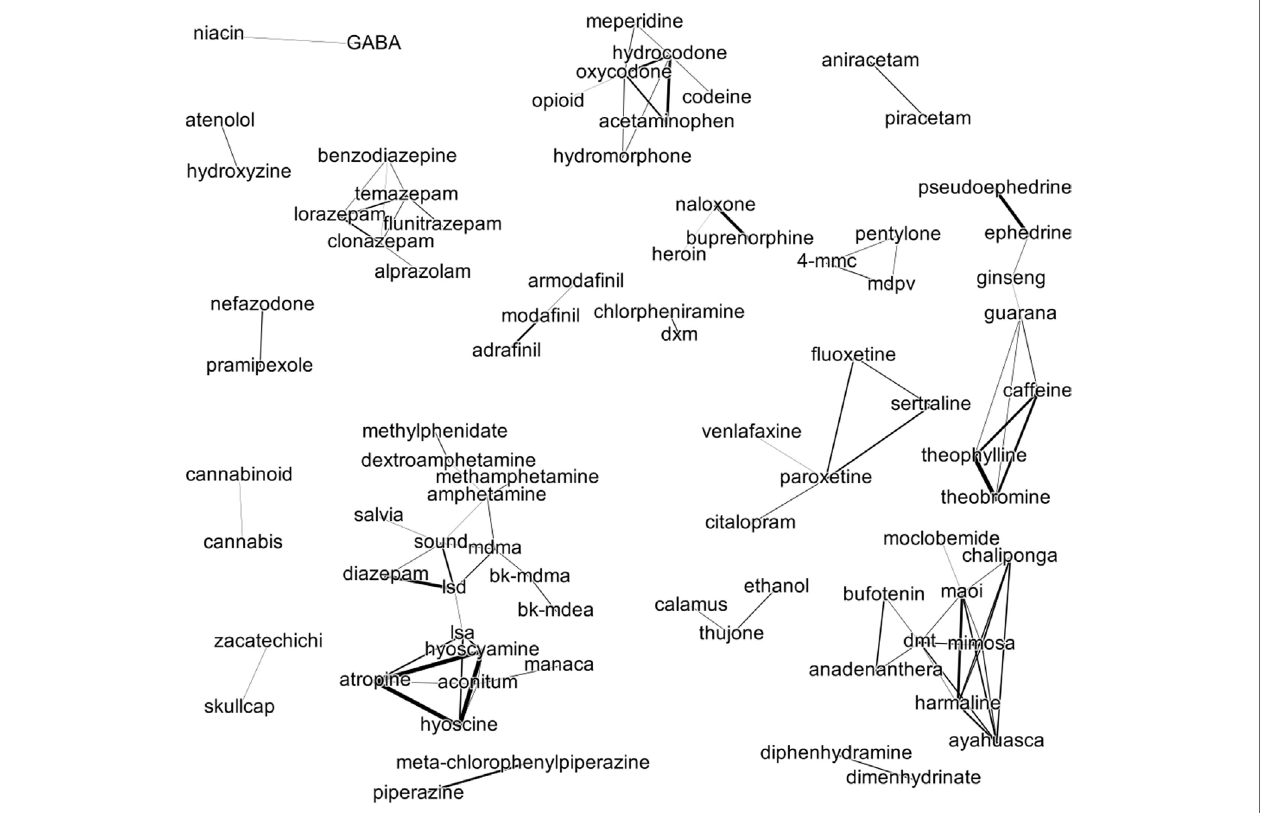
FigUre 4 | Social network of drug discussions. Each node (text) represents a substance. Each edge (connecting line) represents the correlation between mentions of the two connected substances. The thicker the line the stronger the